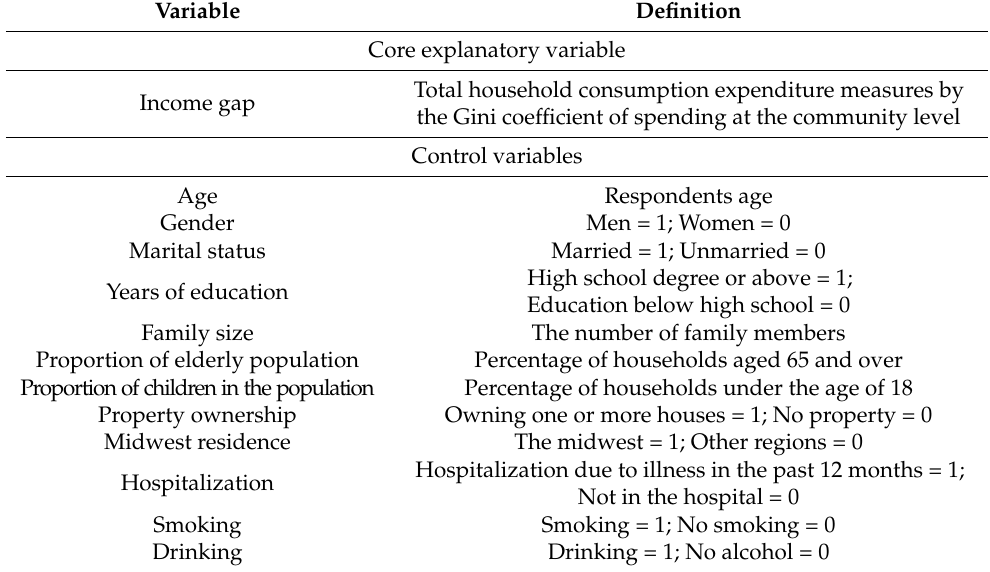
Table 1. Variable definitions.